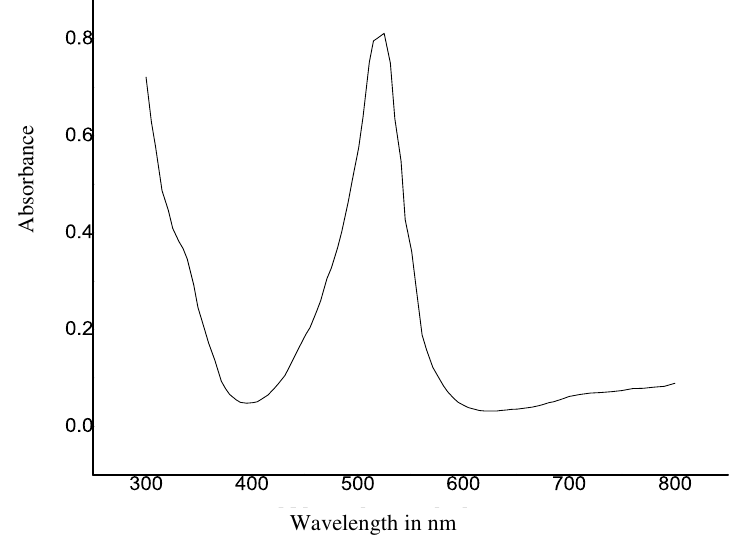
Wavelentgh in nm Figure 5. Absorption spectrum of [Ph + ] [CoCl 4- ] (Co(II) (10 µg) + 0.7 5 mL iodine monochloride (0.009 M) + 1.5 mL Promethazine hydrochloride + diluted to 10 mL with